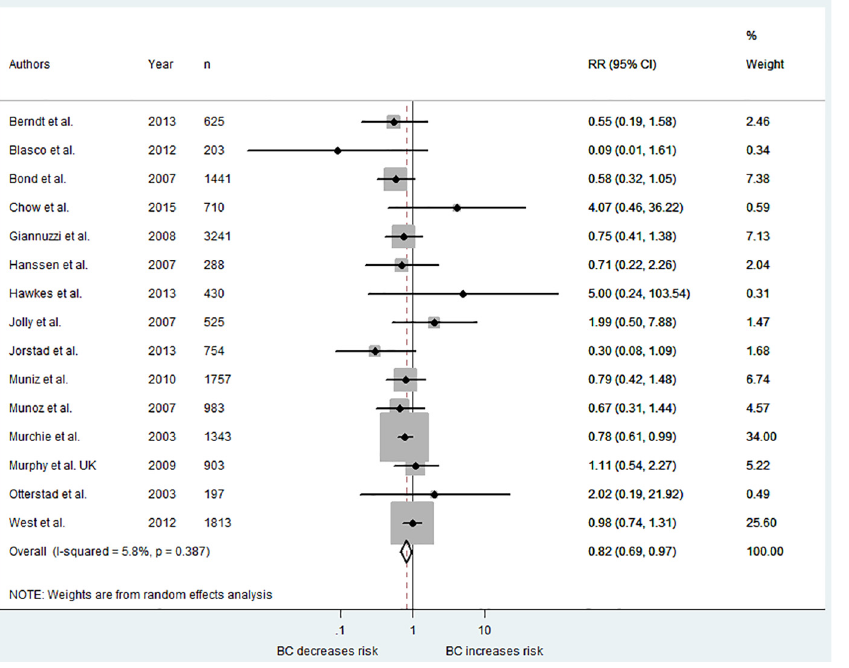
Fig 5. Forest plot showing weighted risk ratio for